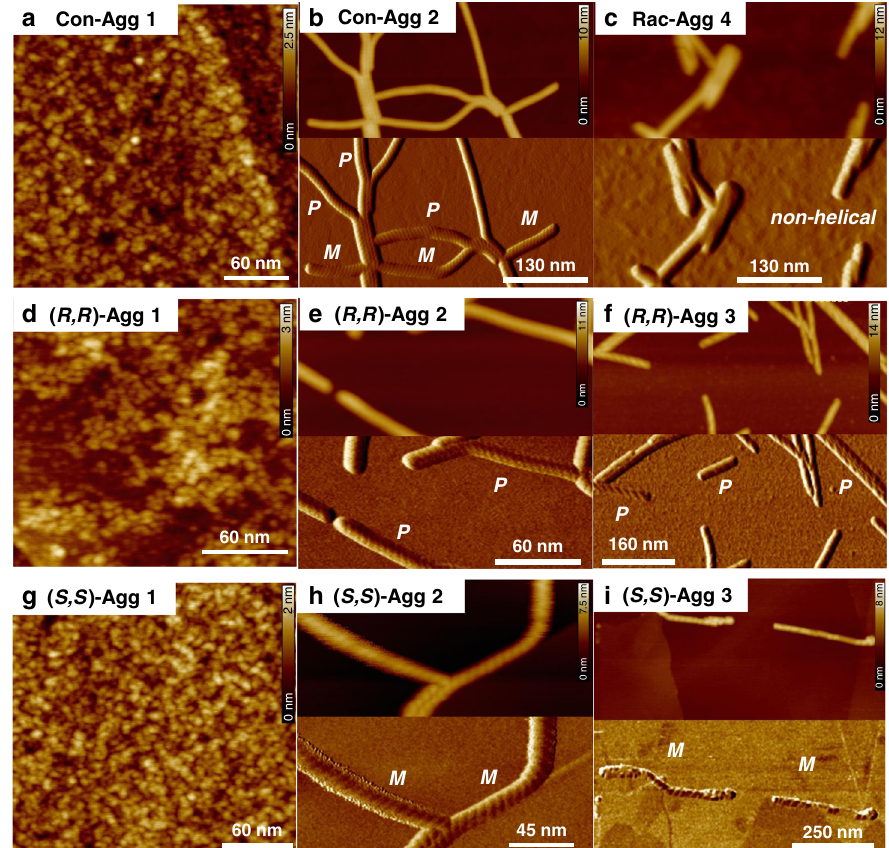
Fig. 2 AFM studies. AFM images of Con-Agg 1 ( a ), Con-Agg 2 ( b ), Rac-Agg 4 ( c ), ( R,R )-Agg 1 – 3 ( d – f ) and ( S,S )-Agg 1 – 3 ( g – i ) spin-coated on HOPG from MCH/Tol (5:4, v / v ). Z scales are 2.5 ( a ), 10 ( b ), 12 ( c ), 3 ( d ), 11 ( e ), 14 ( f ), 2 ( g ), 7.5 ( h ), and 8 nm ( i ), respectively. For Con-Agg 1 , ( R,R )-Agg 1 , and ( S,S )-Agg 1 , only the height images are shown while for the other species both height and phase images are provided. The helicities ( P : right-handed, M : left-handed) of the nano fi bres of Con-Agg 2 as well as ( R,R )- and ( S,S )-Agg 2 and -Agg 3 are indicated in the respective phase